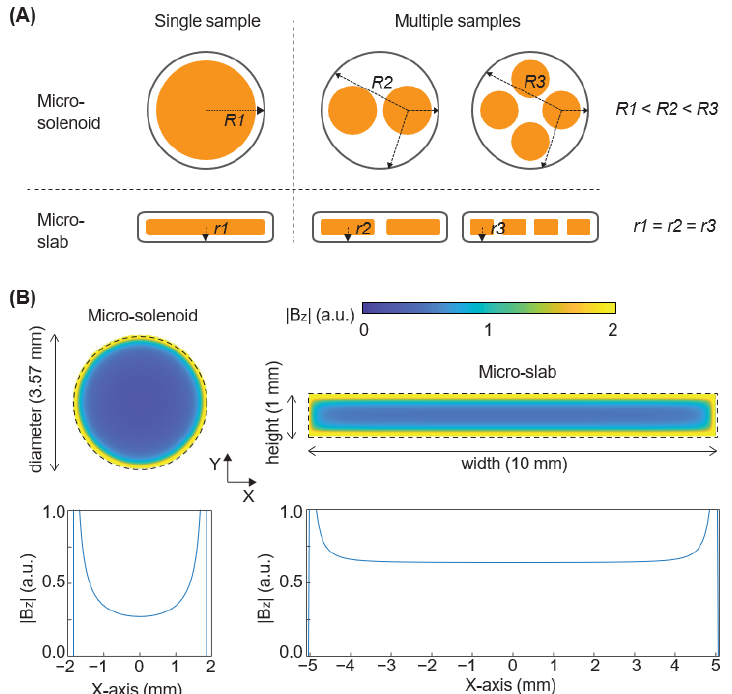
Figure 1. Micro-slab design outperforms micro-solenoid design for magnetic signal detection in multiple samples. ( A ) Schematic comparing the cross-section of a micro-solenoid coil design and a micro-slab coil design. The sample-to-coil distance in the micro-solenoid, R , increases with the number of samples inside, but the sample-to-coil distance in the micro-slab, r , does not increase. ( B ) Electromagnetic simulation comparing the magnitude and uniformity of the magnetic field (B z ) inside a micro-solenoid coil and a micro-slab coil. The simulation was performed with the condition that each coil design had the same cross-sectional area.